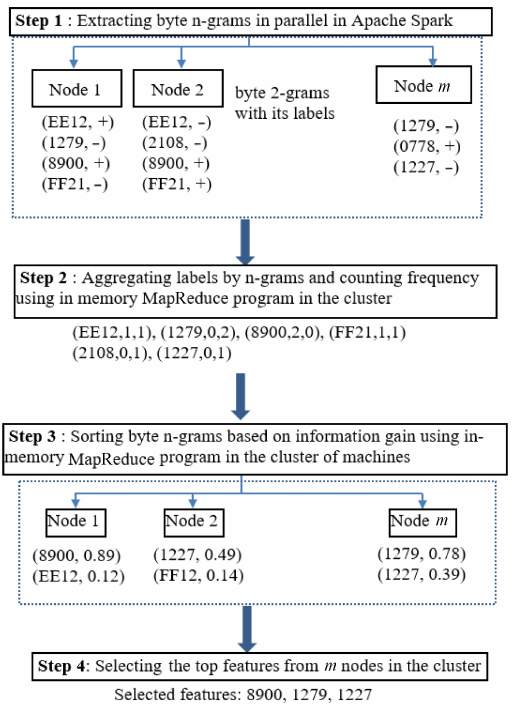
Fig. 2 Major steps to extract important content-based features using the Spark